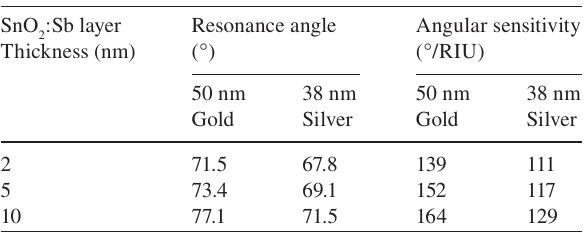
Table 2 Angular sensitivity of 50 nm gold and 38 nm silver fi lms coated with SnO :Sb of same thicknesses. 2